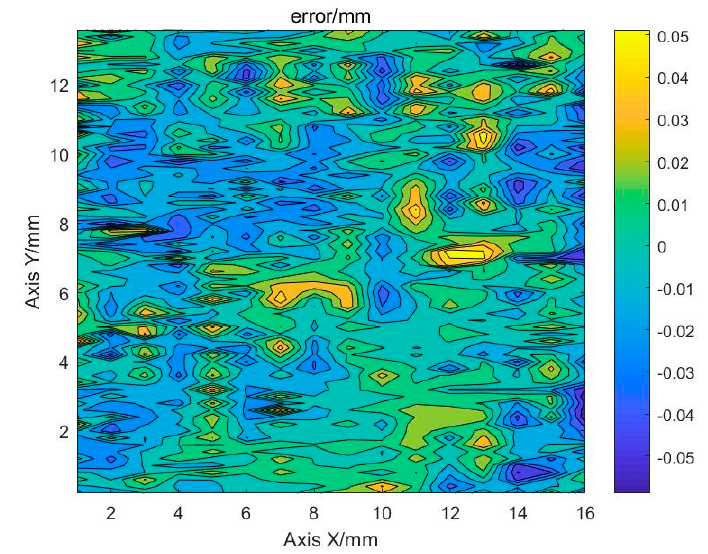
Figure 18. Flatness error after compensation of tilt.